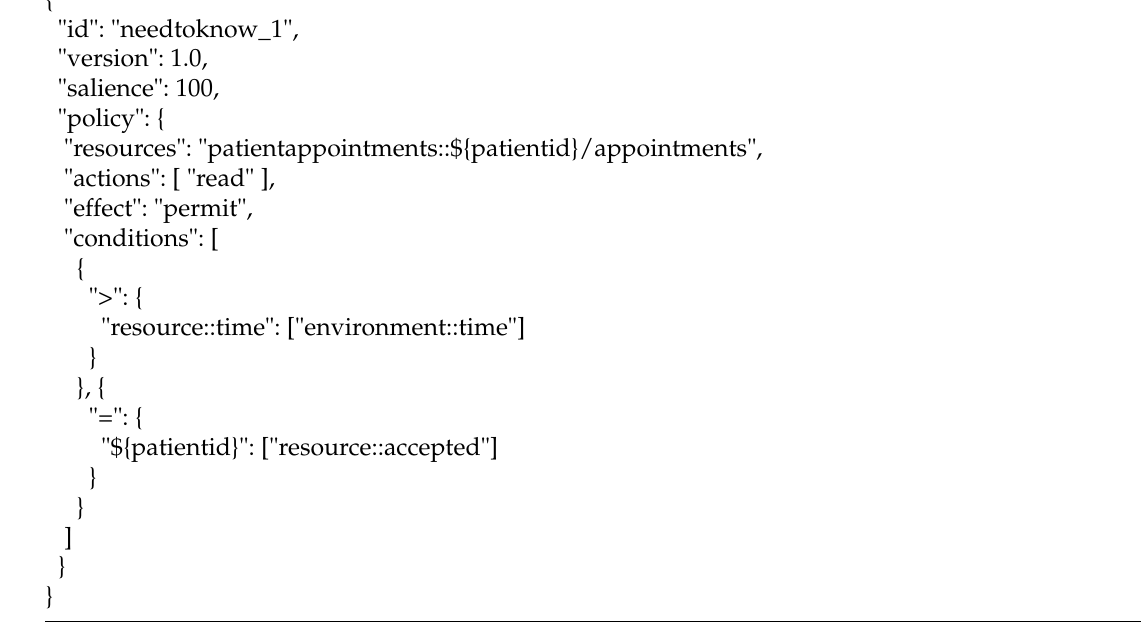
Figure 12. Need-to-know authorization policy for the Medical Records